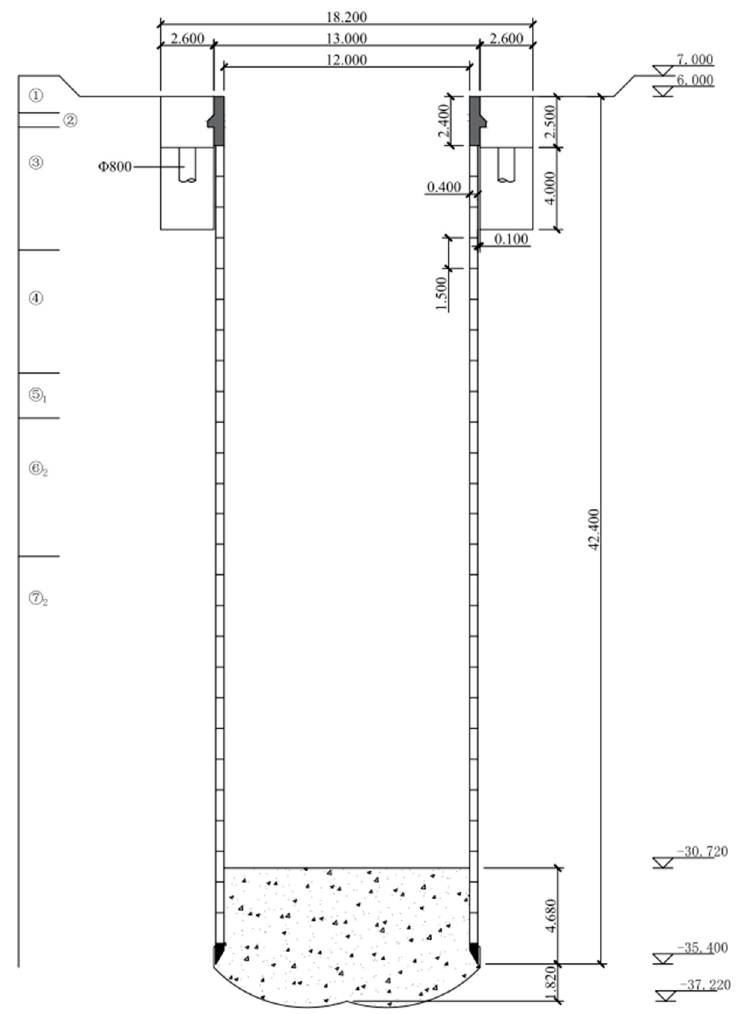
Figure 2. Shaft section layout (m). Table 1. Technical parameters in VSM construction.